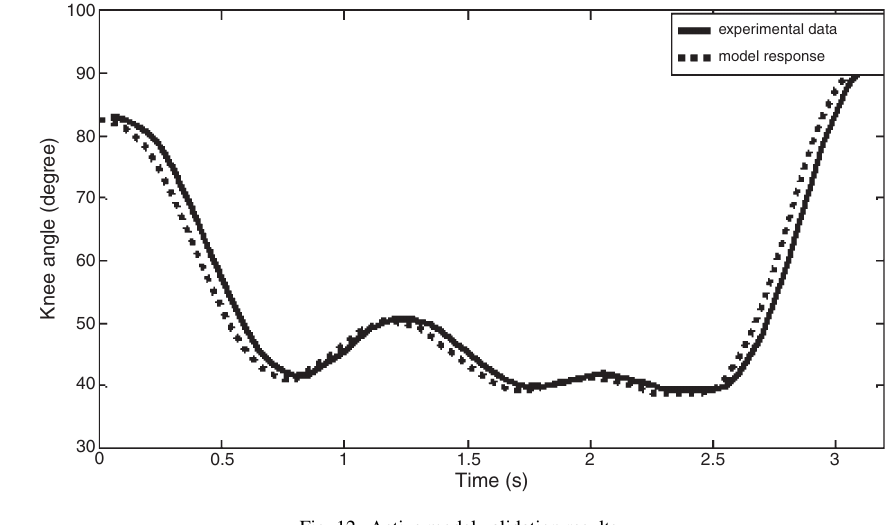
Fig. 12. Active model validation results.